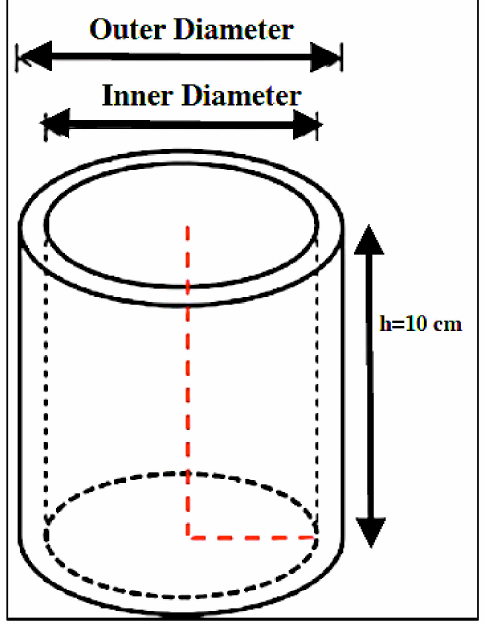
Figure 3. The sample used for the shrinkage